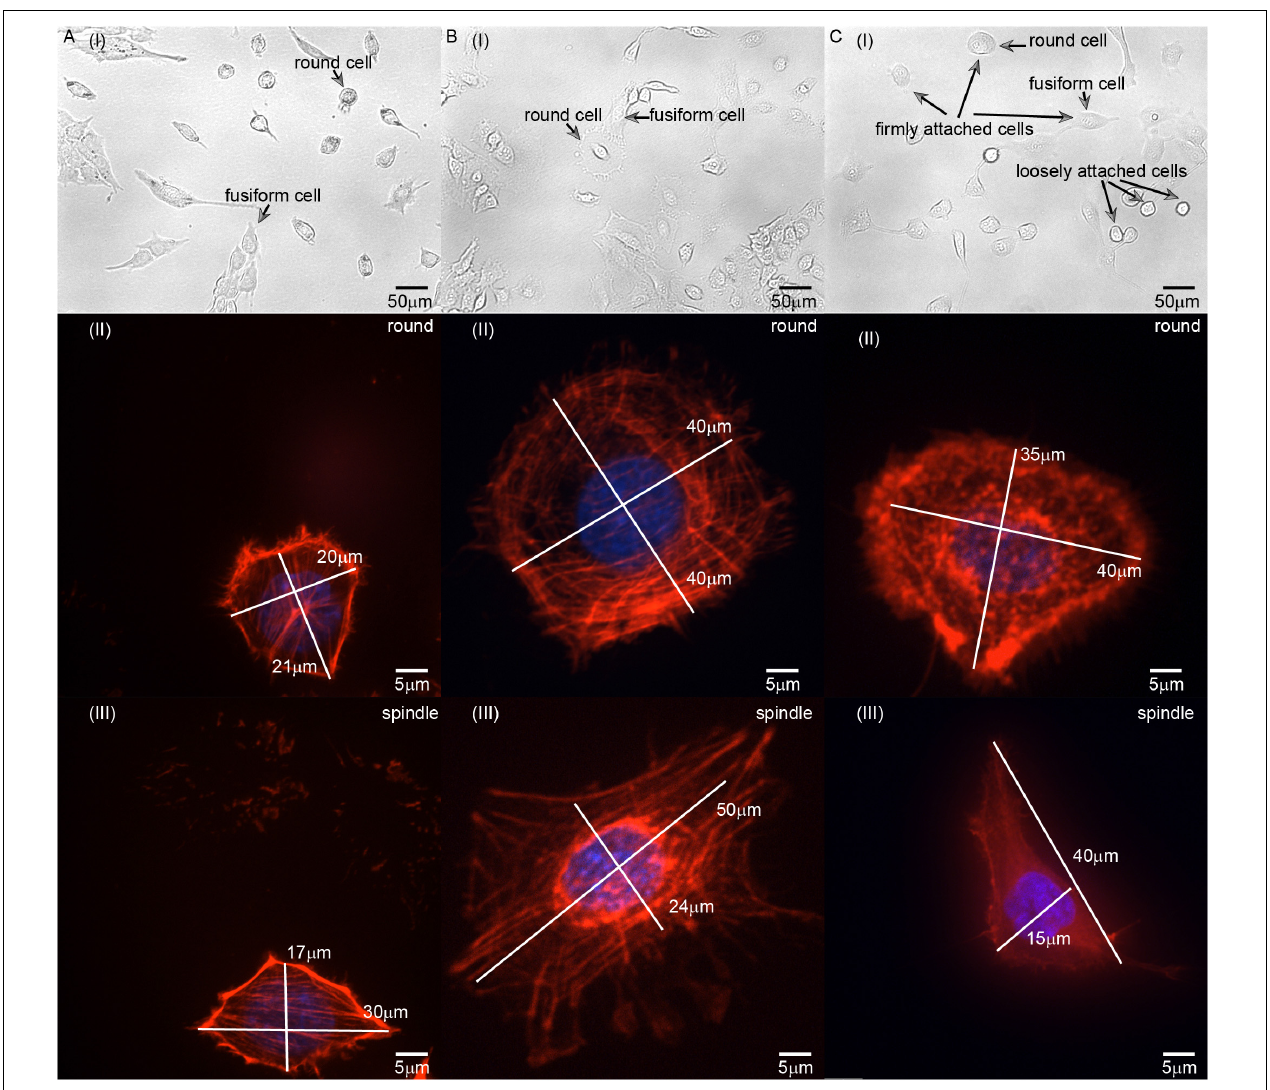
FIGURE 3 | Images of (A) L929, (B) HC11, and (C) MCF-10A cells with different adherent shapes and acquired using optical microscopy and confocal microscopy. [A(I)–C(I)] are the images captured by optical microscope. Examples of round and fusiform cells, loosely attached and firmly attached cells have been marked separately in the figure. [A(II)–C(II)] are the images of round cells captured by laser scanning confocal microscope. [A(III)–C(III)] are the images of fusiform cells captured by laser scanning confocal microscope. The length of the long and short axis of cells has also been marked in [A(II–III)–C(II–III)]